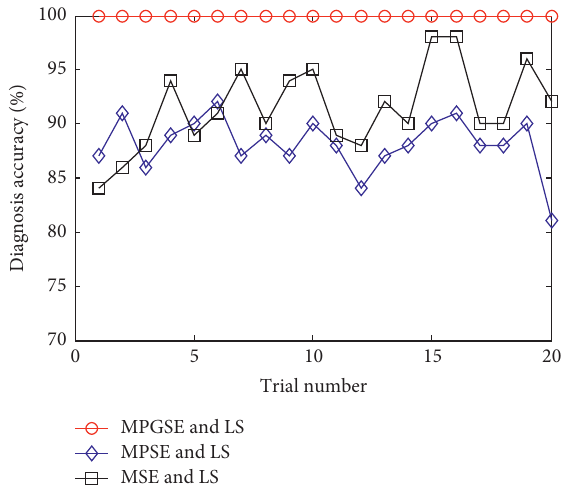
Figure 30: Diagnostic accuracy of 20 trials of three methods in case 2. Table 11: Diagnostic results of different methods with LS feature selection in case